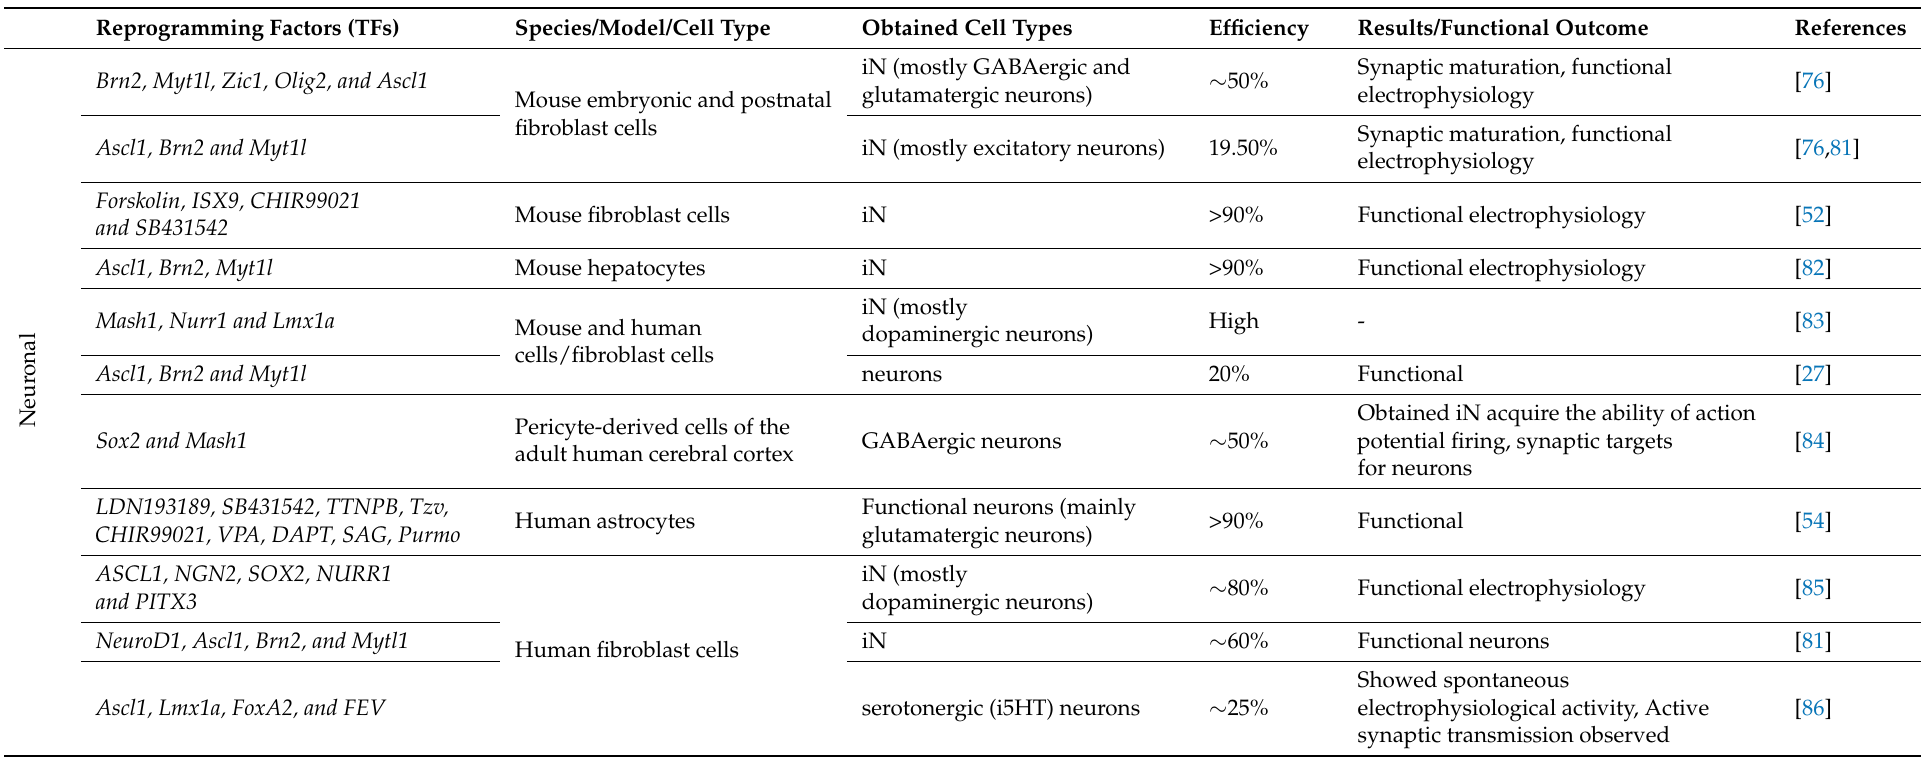
Table 4. TFs-induced cellular reprogramming and functional outcomes in neuronal and cardiac model